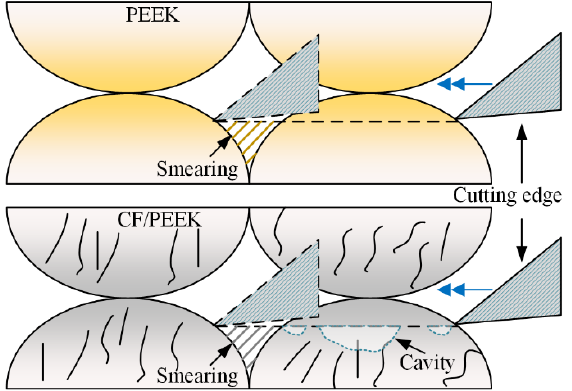
Figure 16. Schematic of the cutting of 3D-printed PEEK and CF/PEEK samples.